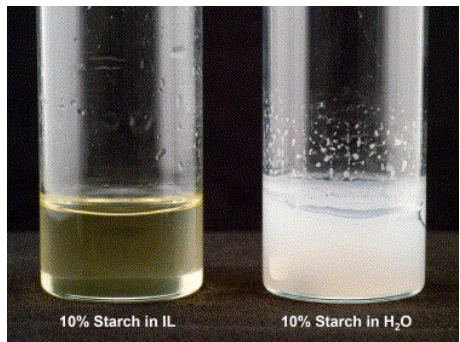
Figure 7. Picture demonstrating total solubilization of starch (wt.%) in 1-butyl-3-methylimidazolium dicyanamide and partial solubilization in water. Reprinted from [52], with permission from